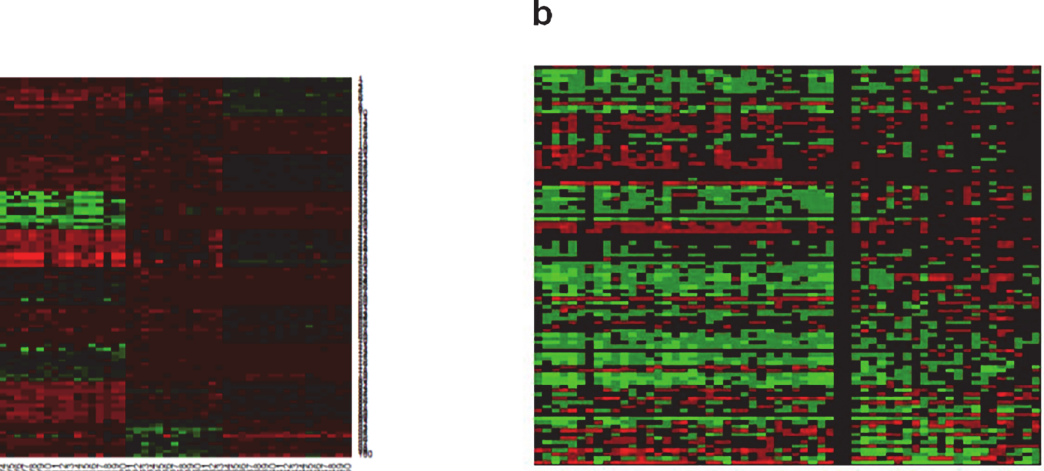
Fig 2. Heat maps clearly show the patterns of MBI co-clusters. For the gene expression datasets studied here, MBI co-clustering simultaneously provide the gene (row) groupings and the sample (column) groupings, identifying the genes associated with the different types or subtypes. (a) Heat map shows clear co-clusters identified by MBI. The plot is based on real values of Y matrix of gene expression profiling data (data1 with three types: COID/20, CM/13, NL/17; refer to S1 File). Each row corresponds to one gene; each column corresponds to one sample. This heat map shows the expression values of 100 genes across all the 3 different types. (b) Heat map shows clear co-clusters identified by MBI. The plot is based on the values of Y matrix for Canada stage1 dataset (heat map for Canada stage1 dataset with 562 genes with k 1 = 100 and k 2 = 2. The two groups are separated by a thick black vertical